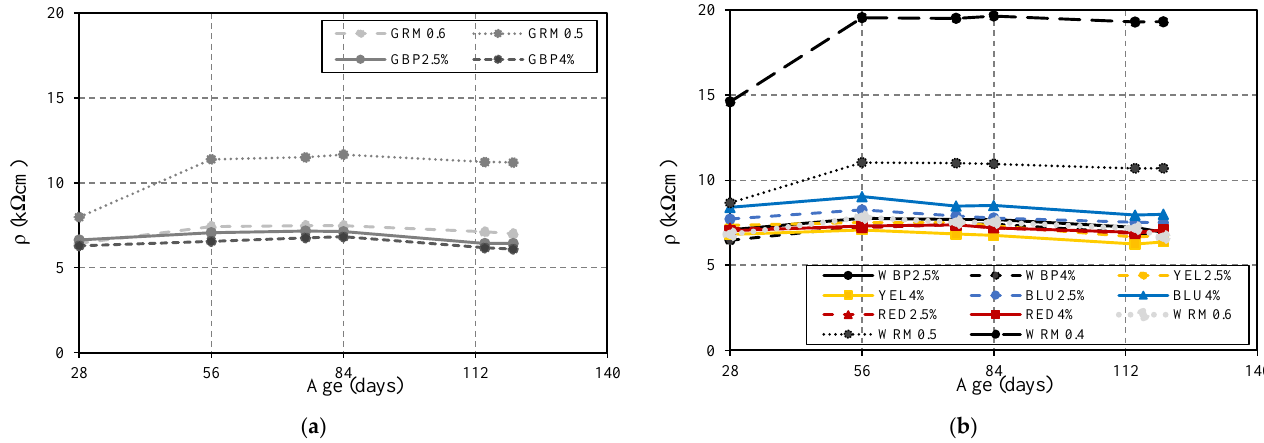
Figure 6. Electrical resistivity as a function of age: ( a ) GRM0.6, GRM0.5, GBP2.5%, GBP4%; ( b ) WRM0.6, WRM0.5, WRM0.4, WBP2.5%, WBP4%, YEL2.5%, YEL4%, BLU2.5%, BLU4%, RED2.5%, RED4%.